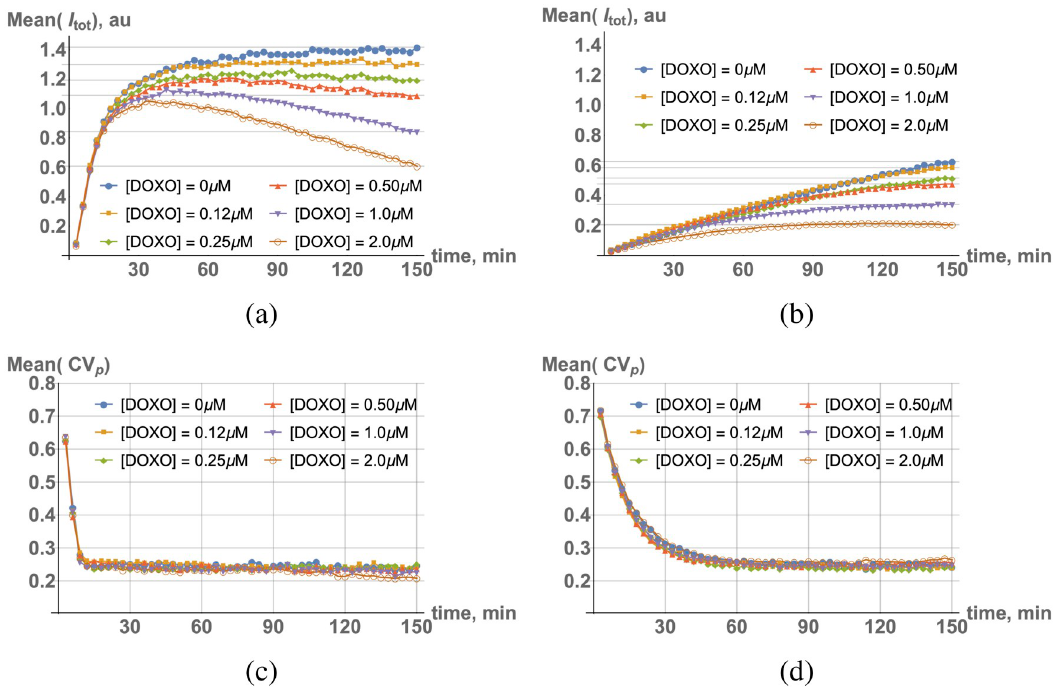
Fig 7. Population average I time dependences for different doxorubicin concentrations in live cell culture, (a) [dye] = 8 μM and tot (b) [dye] = 0.25 μM . (c) and (d): Population average CV p , same conditions as above.